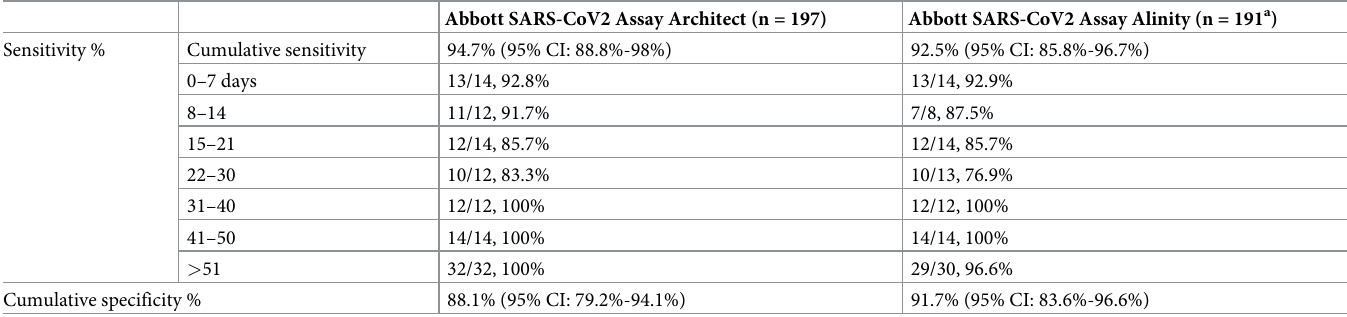
Table 5. Abbott anti-SARS-CoV-2 Architect and Alinity assays sensitivity of each assay compared with in-house ELISA. Abbott SARS-CoV2 Assay Architect (n = 197)